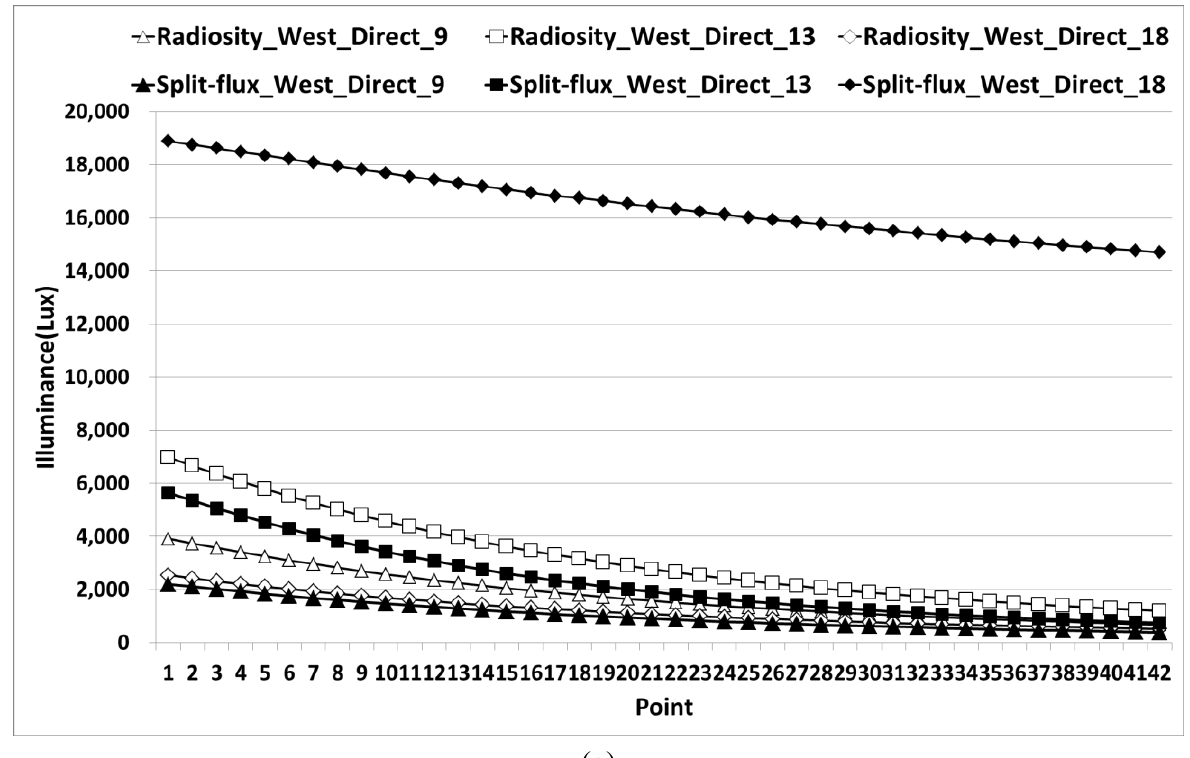
Figure 5. Direct and Diffuse interior illuminance from Split-flux and Radiosity at